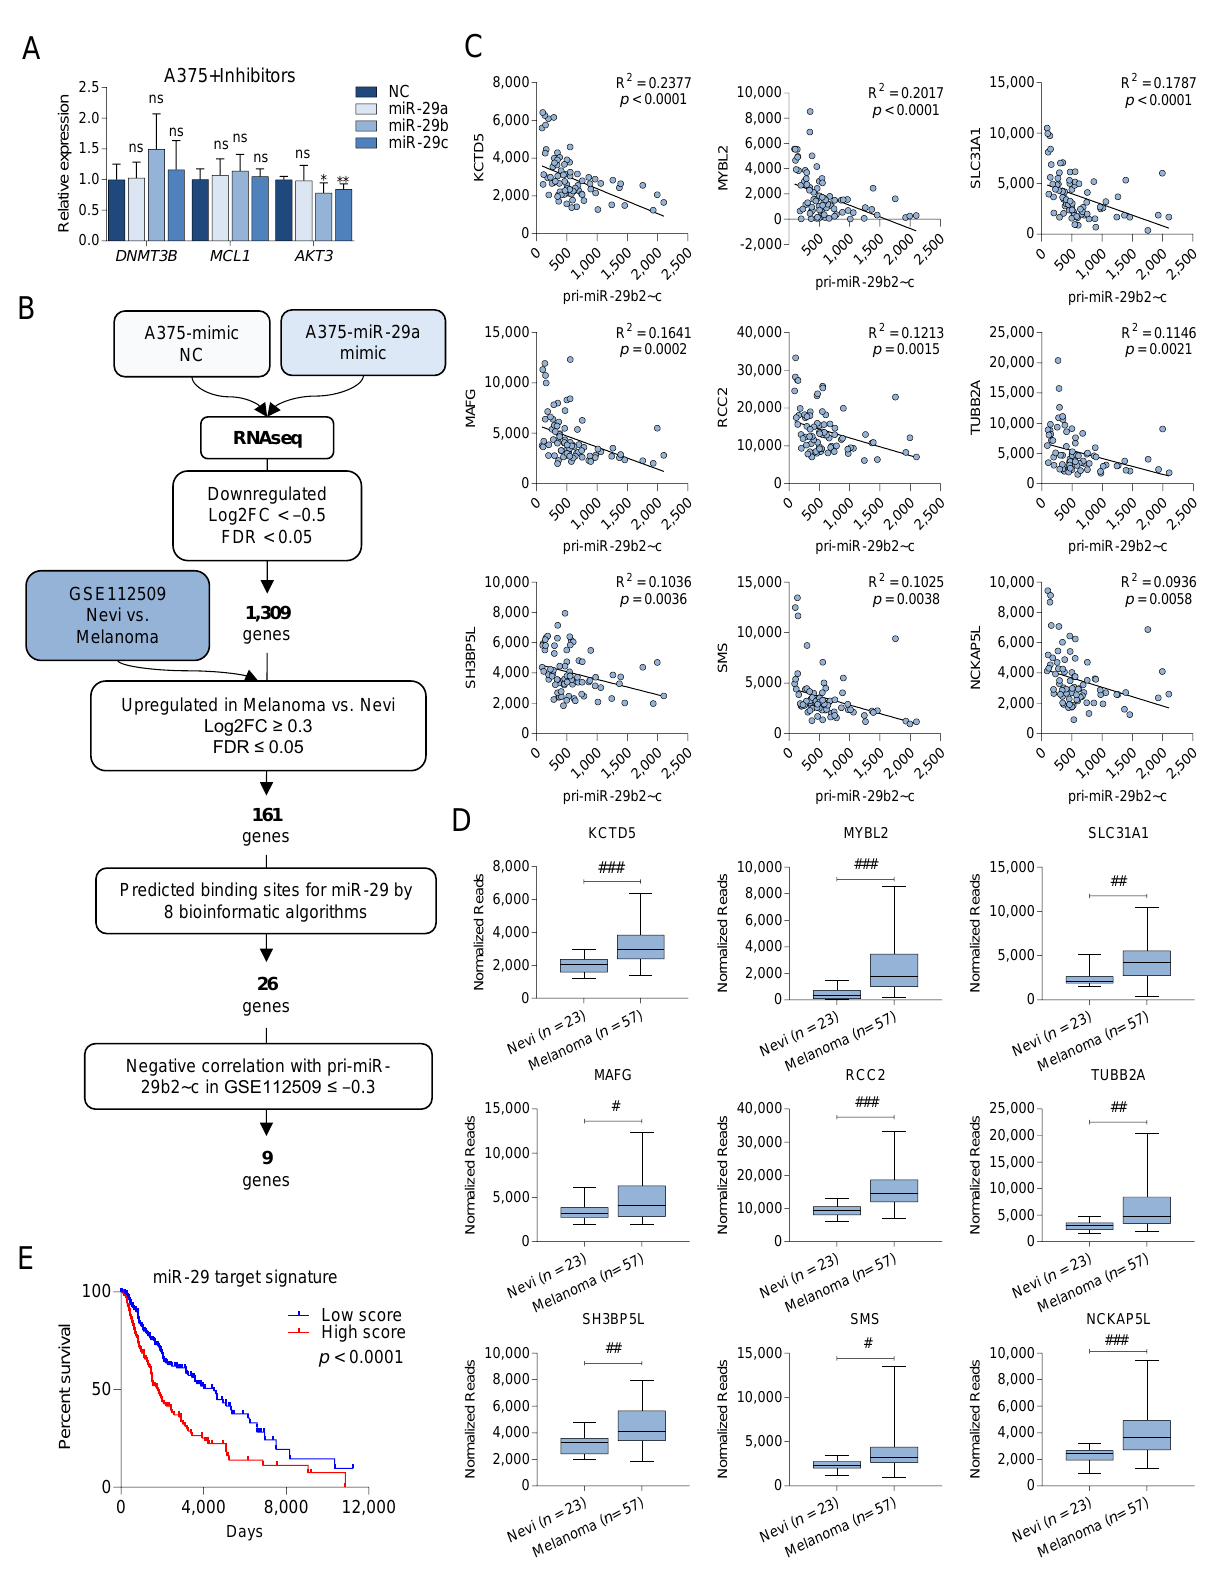
Figure 3. Identification of new miR-29 targets in melanoma. ( A ) Quantification by qRT-PCR of three validated miR-29 target genes of miR-29 after overexpression of miR-29 mimics in A375 cells. Cells overexpressing a negative control mimic were used as control; ( B ) selection flowchart to identify target genes of miR-29 involved in melanoma progression; ( C )